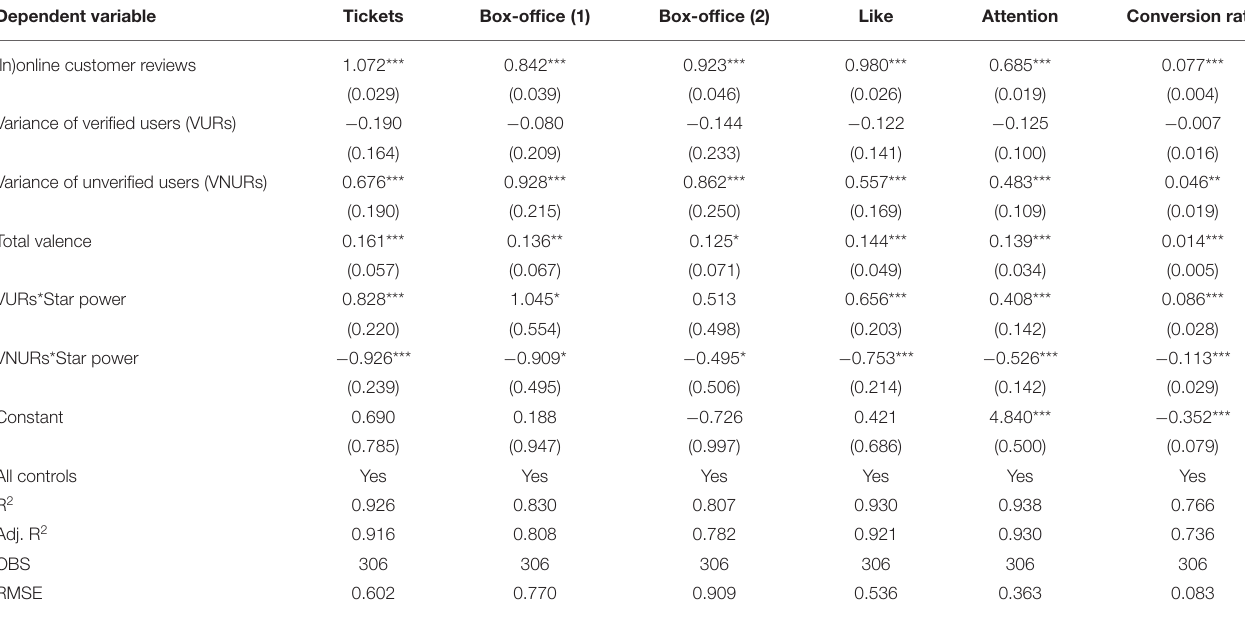
TABLE 5 | Robustness test for the different dependent variable (Model